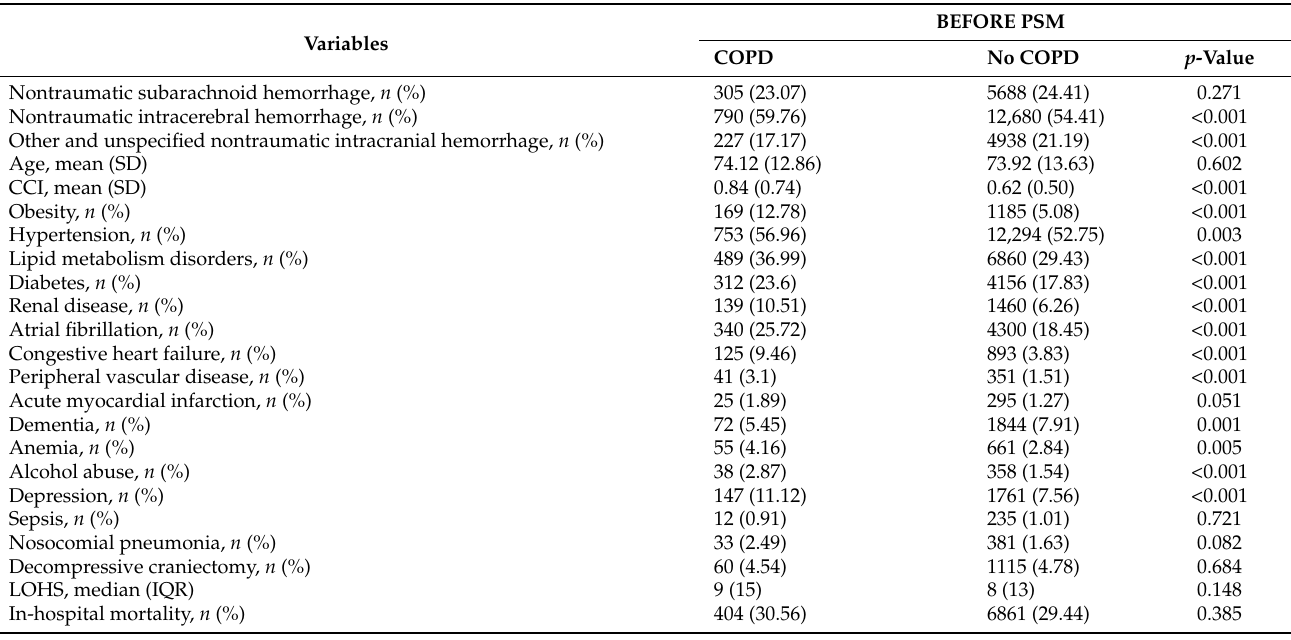
Table 3. Clinical characteristics, use of therapeutic procedures, and hospital outcomes before propensity score matching in women patients with hemorrhagic